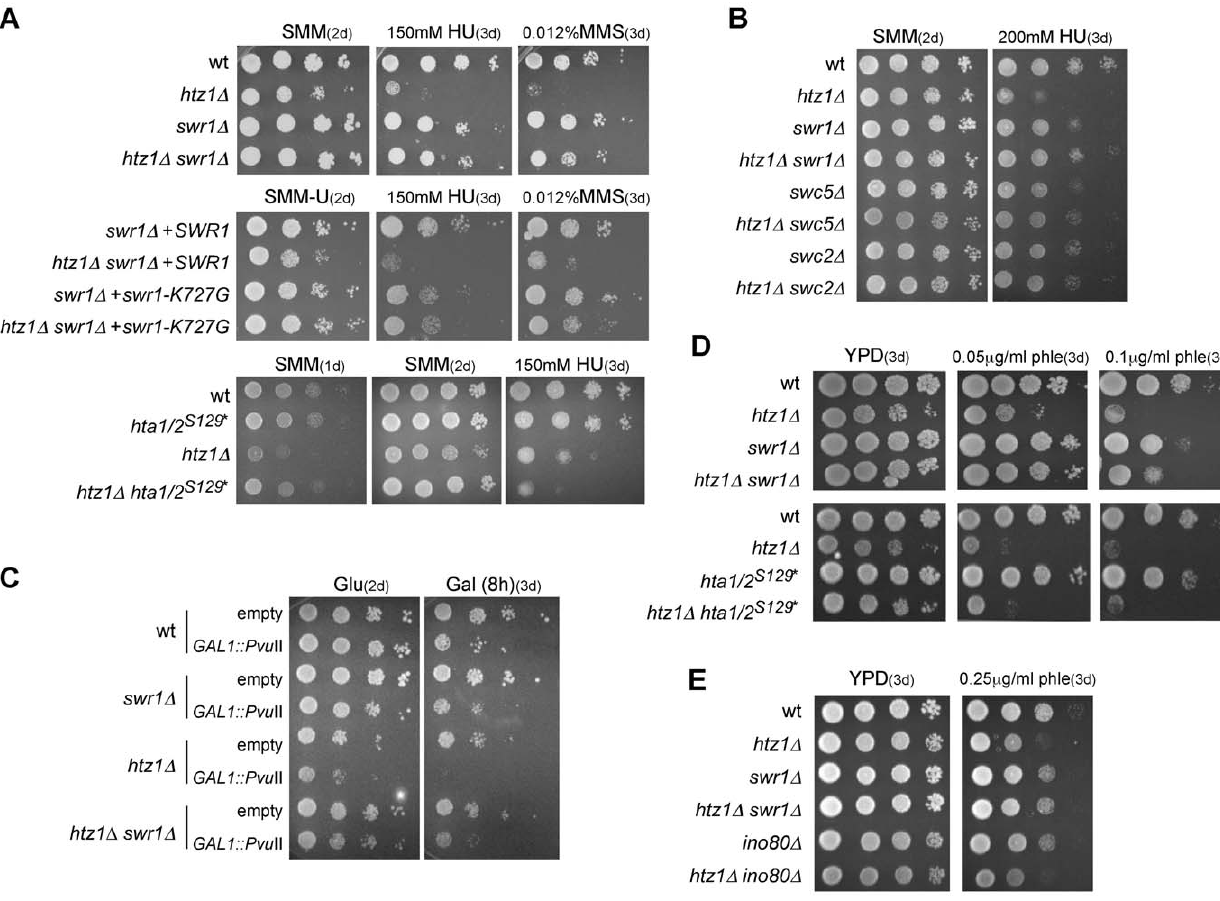
Figure 2. The SWR1 complex causes DNA damage sensitivity in the absence of Htz1. ( A ) DNA damage sensitivity of htz1 D , swr1 D , htz1 D swr1 D , hta1/2 S129* , htz1 D hta1/2 S129* and of swr1 D and htz1 D swr1 D transformed with plasmids pRS416-SWR1-2Flag or p416-swr1-2Flag-k727G (W303- 1a) as determined by plating ten-fold serial dilutions from the same number of mid-log phase cells onto SMM or SMM-U plates with or without HU or MMS, respectively. ( B ) DNA damage sensitivity of htz1 D , swr1 D , swc2 D , swc5 D , htz1 D swr1 D , htz1 D swc2 D and htz1 D swc5 D (BY4741) as indicated in (A). ( C ) Sensitivity of htz1 D , swr1 D and htz1 D swr1 D (W303-1a) to DSBs generated by expression of the endonuclease Pvu II from a GAL1 promoter variant. DSB sensitivity of cells transformed with either pV10 ( GAL1 pr:: Pvu II) or pRS316 (empty vector) was determined by plating onto SMM-U ten- fold serial dilutions from the same number of mid-log phase cells growth under non-inducing (glucose) or inducing (galactose for 8 hours) conditions. ( D ) DSB sensitivity of htz1 D , swr1 D , htz1 D swr1 D , hta1/2 S129* and htz1 D hta1/2 S129* (W303-1a) as determined by plating ten-fold serial dilutions from the same number of mid-log phase cells onto YPD with or without phleomycin. ( E ) Phleomycin-induced DSBs sensitivity of htz1 D , swr1 D , htz1 D swr1 D , ino80 D and htz1 D ino80 D (BY4733) as determined in (D). Cells were incubated at 30 u C for 1–3 days as indicated.